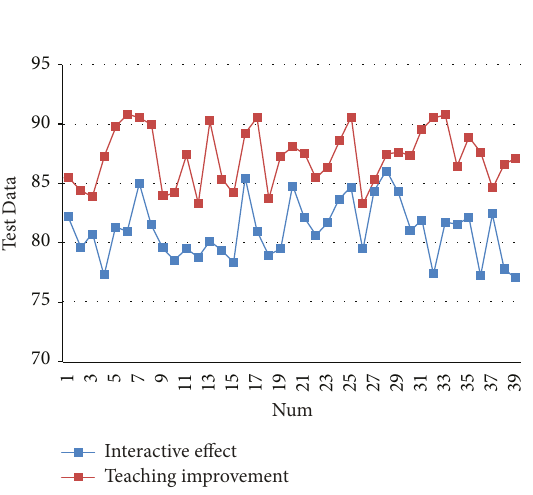
Figure 11: Statistical diagram of test